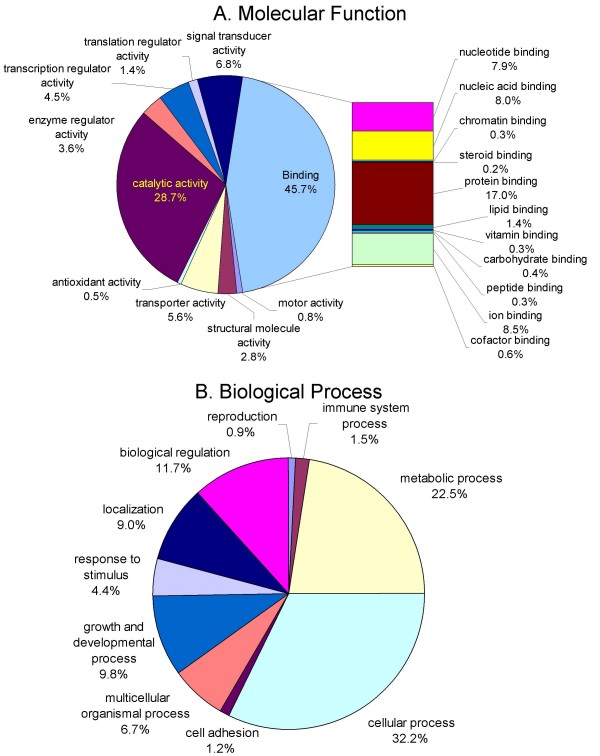
Classification of EST according to Gene Ontology. Distribution of goldfish olfactory epithelium unigenes classified using GeneOntology categories of (A) Molecular Function and (B) Biological Process.